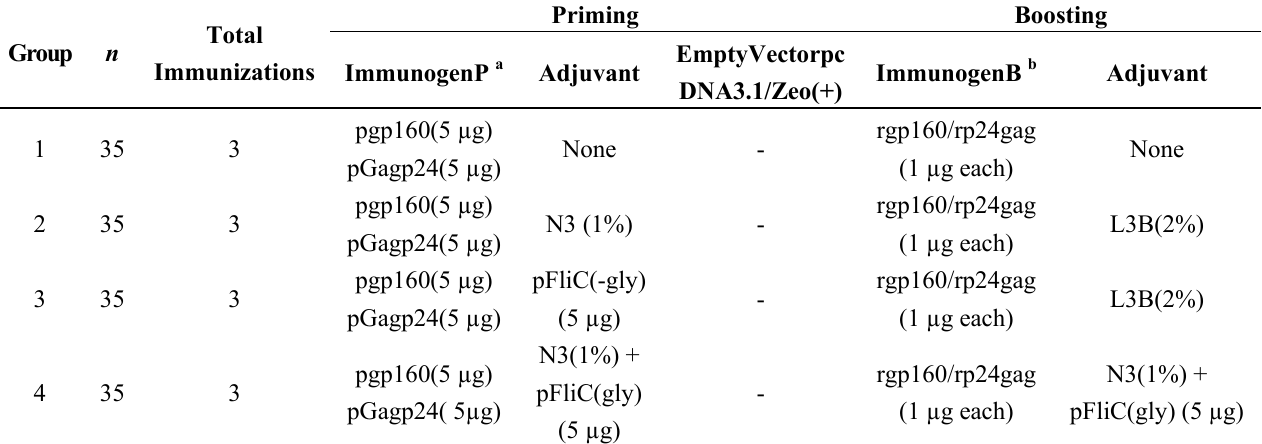
Table 2. Vaccinated groups for gp160/p24gag